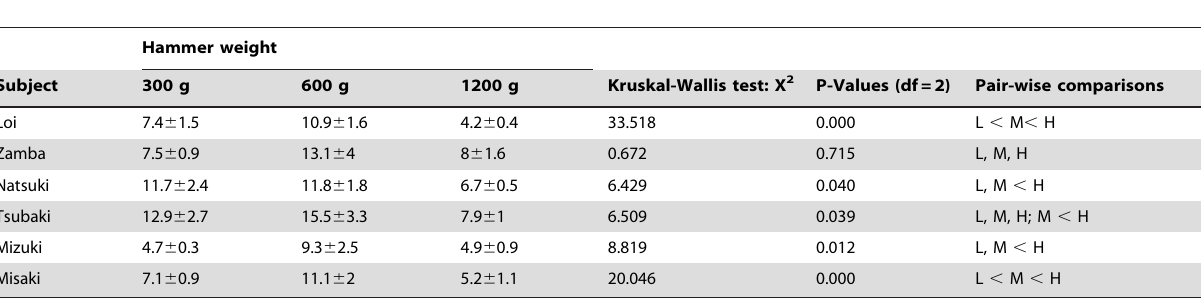
Table 2. Average time ( 6 SE) to solution for all subjects as a function of hammer weight.